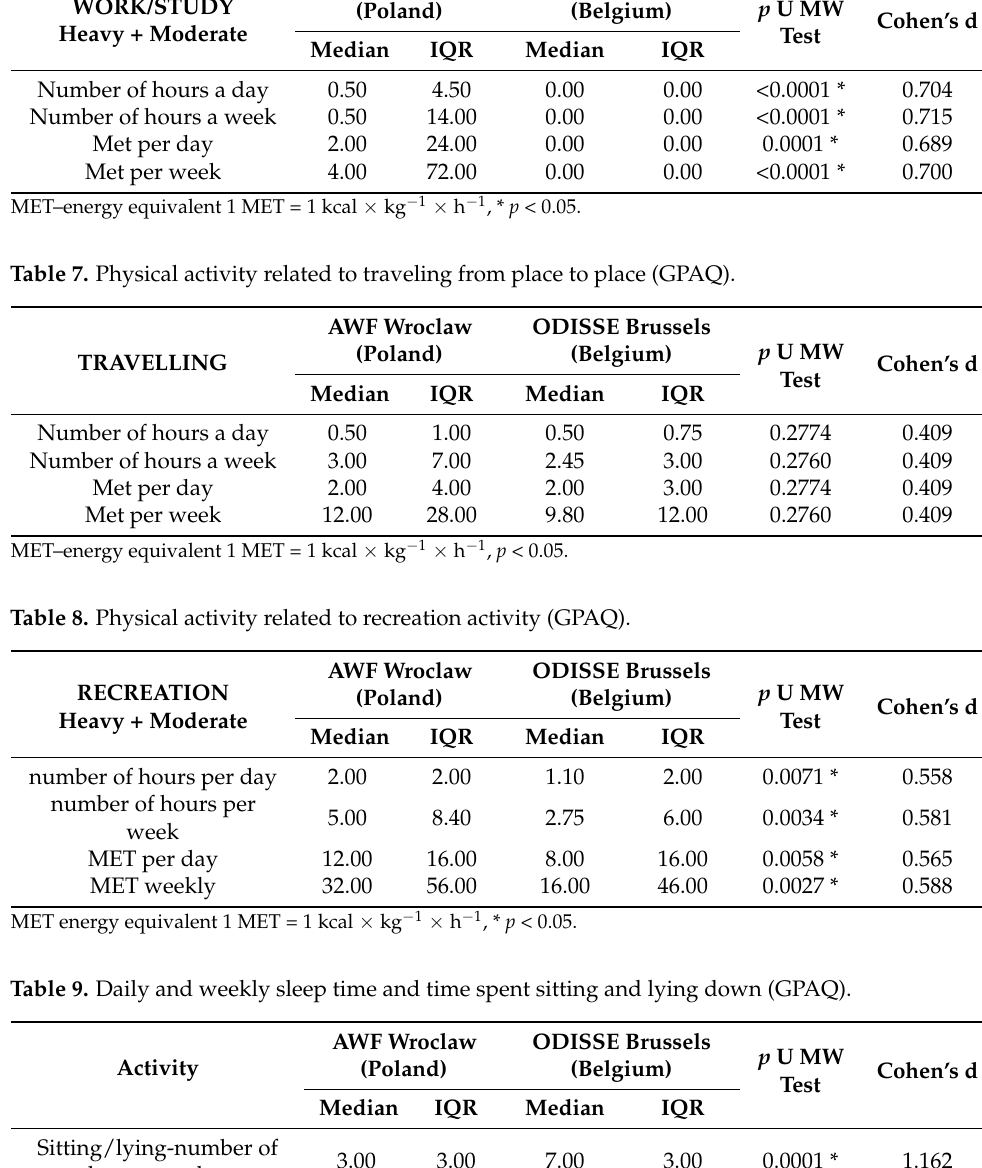
Table 6. Physical activity related to work/study (GPAQ). WORK/STUDY